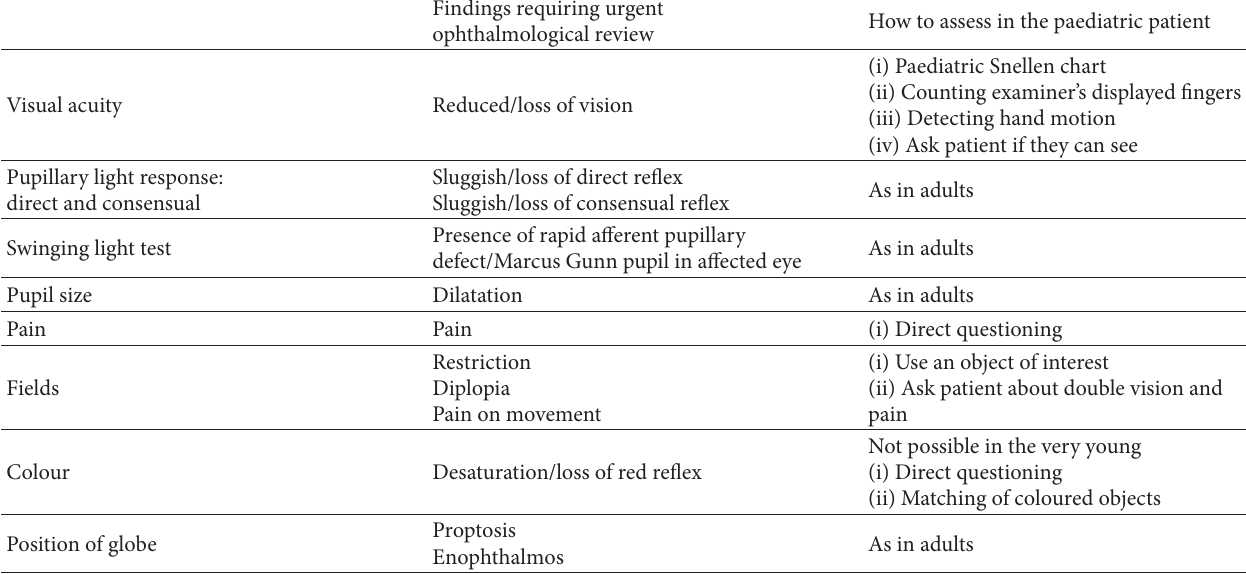
Table 1: Ophthalmological